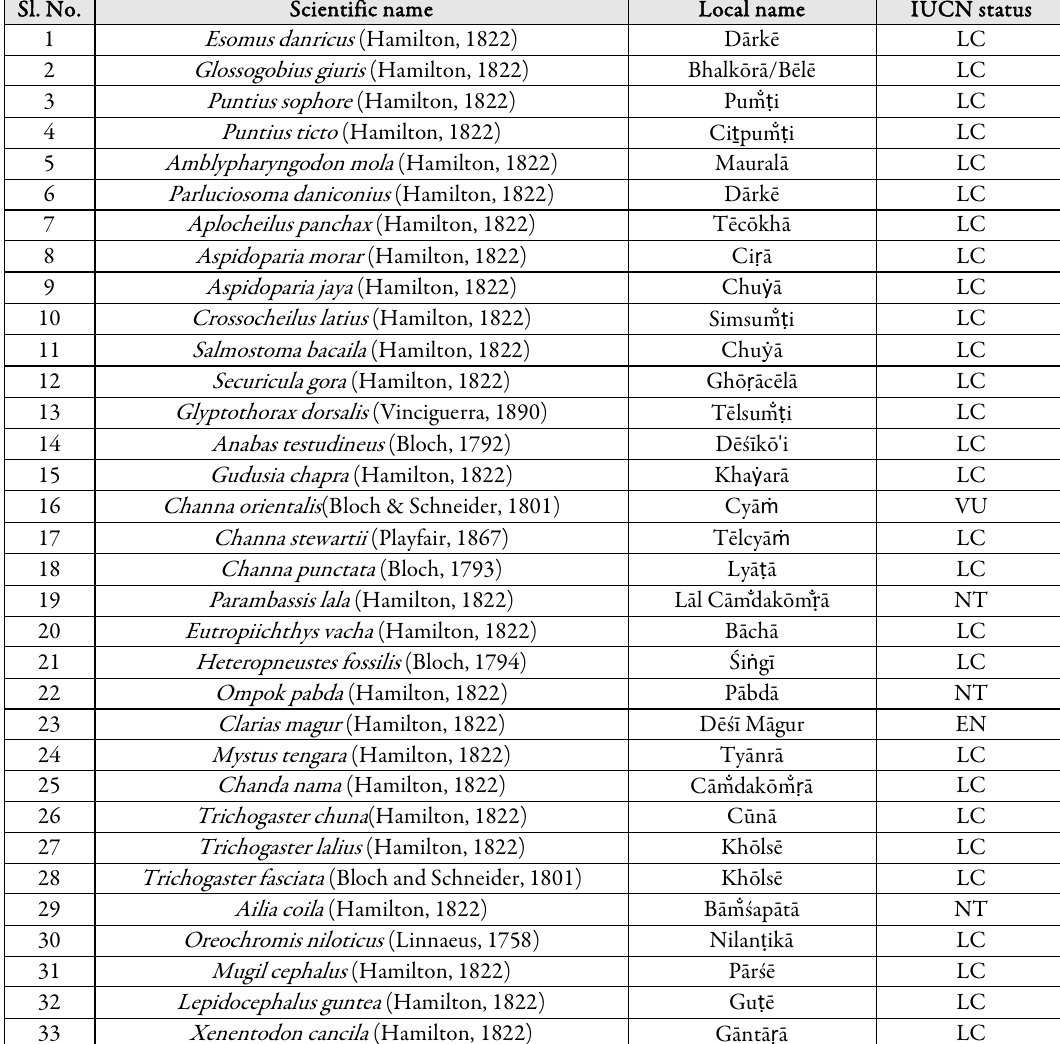
Table 3. Small indigenous fishes of Bankura district Sl.